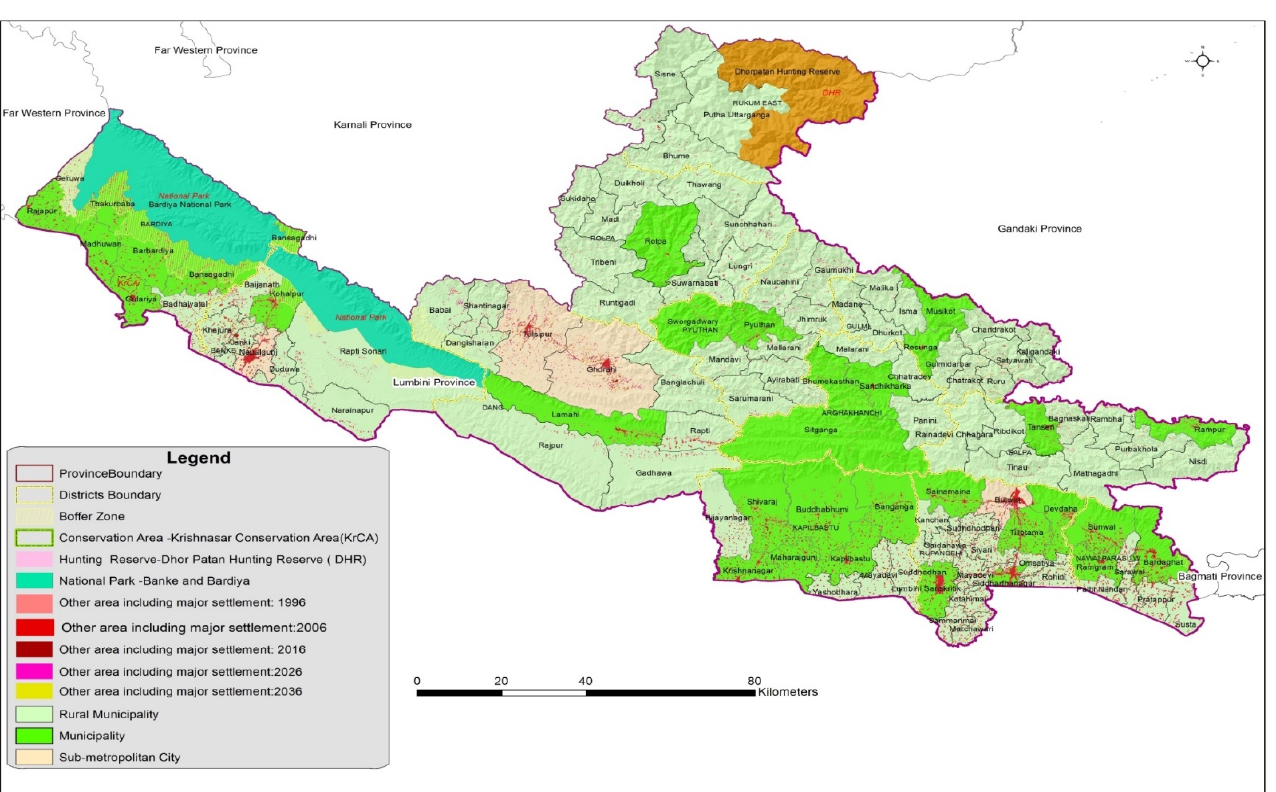
Figure A1. Map 1: Protected area, Sub-Metropolitan City, Municipality and Rural Municipality of Lumbini Province.